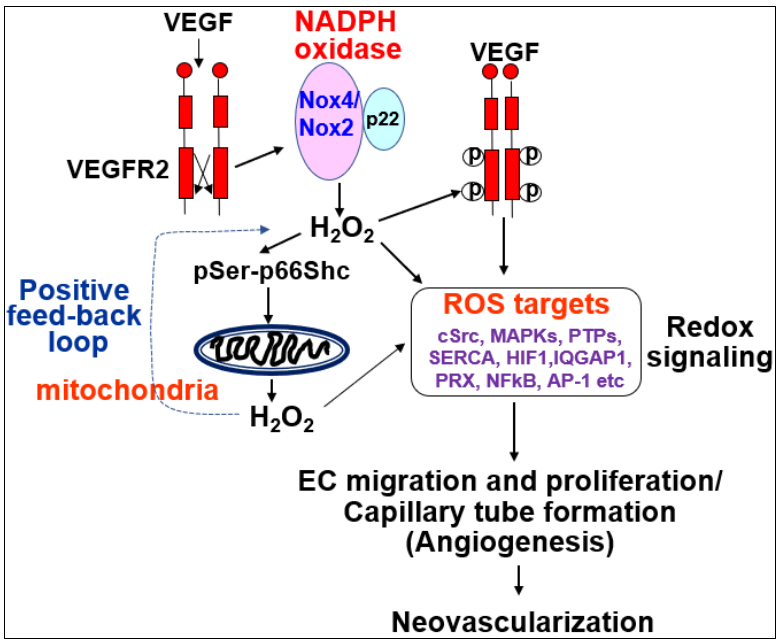
Figure 6. NOX–mitochondria cross ‐ talk in VGEF signaling and angiogenesis.